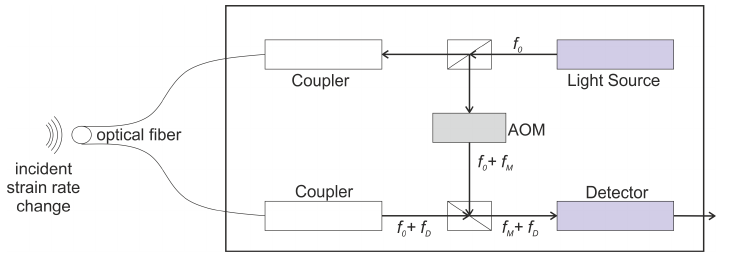
Figure 10. Optical circuit for FOD interrogation (Figure redrawn with permission from [79]